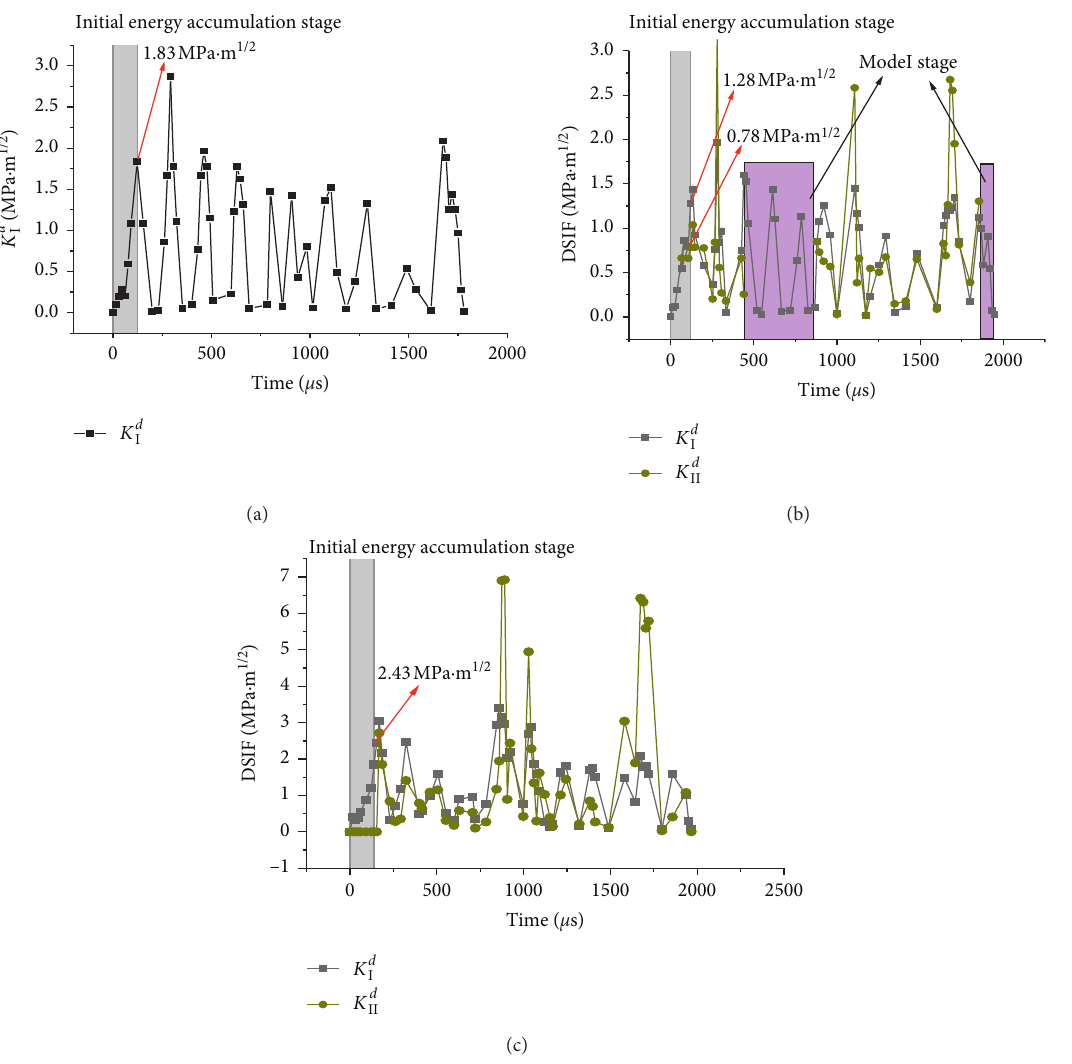
Figure 13: DSIF versus time results for different precrack locations. (a) a � 0 mm. (b) a � 5 mm. (c) a �